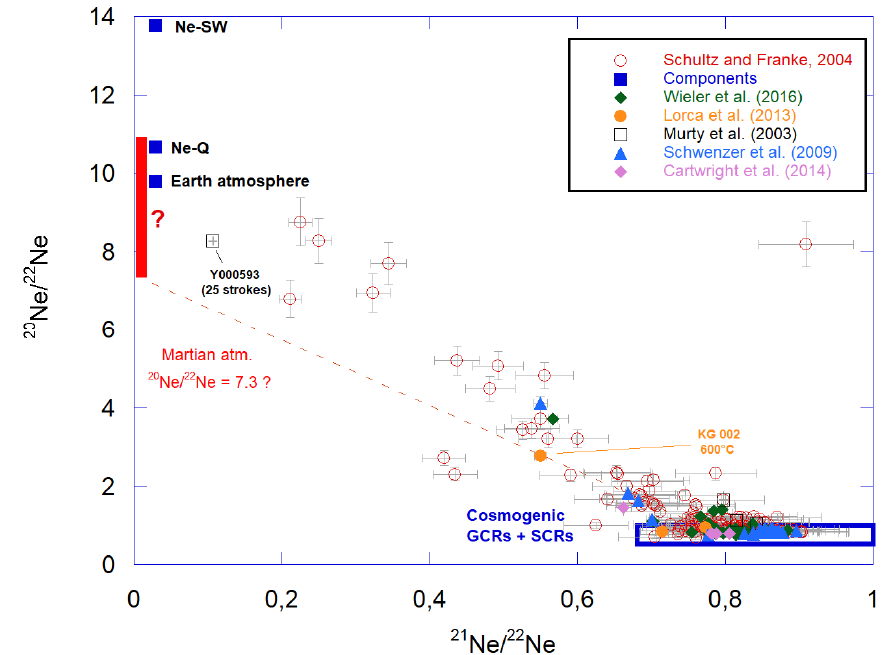
Figure 4. Neon-three isotope plot for measured Martian meteorites [47–73], Y000593, Y000027, Y000097 [75,76], and NWA 7034 [77]. The terrestrial atmosphere, Ne-Q, and Ne-SW components are also reported. Error bars are reported in light gray. The thick red line represents the range of Ne isotopic ratios for the Martian atmosphere, as reported in [35–61]. Adapted and modified after the works in [36–61].